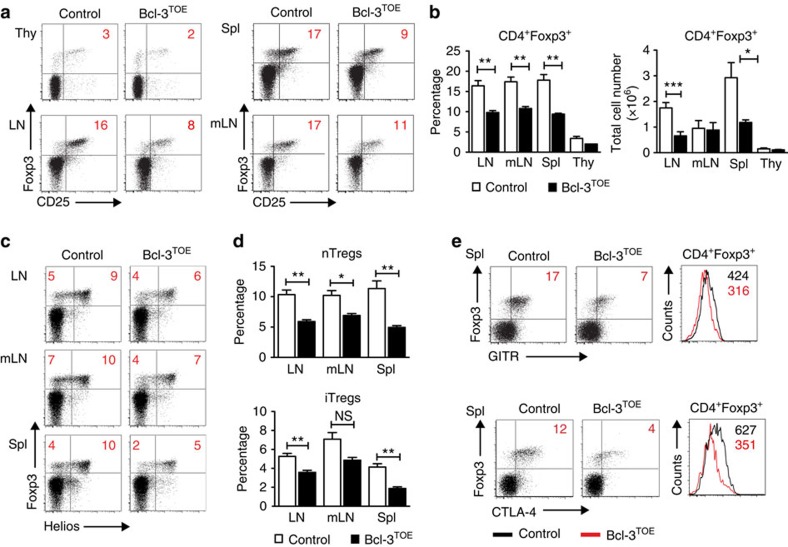
Reduced numbers of Tregs in Bcl-3TOE mice.(a) Flow cytometric analysis of Foxp3+CD25+ Treg cells from thymocytes (Thy), splenocytes (Spl), LNs and mLNs of Bcl-3TOE (n=4) mice and littermate controls (n=4). Numbers in quadrants represent percentage. Cells were gated on live CD4+ T cells. Data shown are representative for at least three independent experiments with similar results. (b) Percentage (left) and absolute cell numbers (right) of CD4+Foxp3+ T cells in LN, mLN, spleen (Spl) and thymus (Thy) from Bcl-3TOE (n=4) mice compared with littermate controls (n=4). Graphs show mean±s.e.m. *P<0.05, **P<0.01 and ***P<0.001 using unpaired Student's t-test. (c) Flow cytometric analysis of LN, mLN and Spl cells gated on CD4+ T cells for expression of Foxp3 and Helios (d), and assigned to either nTregs (Foxp3+Helios+) or iTregs (Foxp3+Helios−). (d) Upper panel: percentage of nTregs of Bcl-3TOE mice (n=4) compared with littermate control mice (n=4). Lower panel: percentage of iTregs of Bcl-3TOE mice (n=4) compared with littermate control mice (n=4) in LN, mLN and Spl. Graphs show mean±s.e.m. *P<0.05, **P<0.01 and ***P<0.001, NS, nonspecific using unpaired Student's t-test. (e) Flow cytometric analysis of splenocytes from Bcl-3TOE and littermate controls gated on CD4+ and analysed for Foxp3, GITR and CTLA-4 expression. n=3. Numbers in quadrants represent percentages (left). Histograms display the mean fluorescence intensity (right). Bcl-3OE mice without Cre were used as littermate controls.